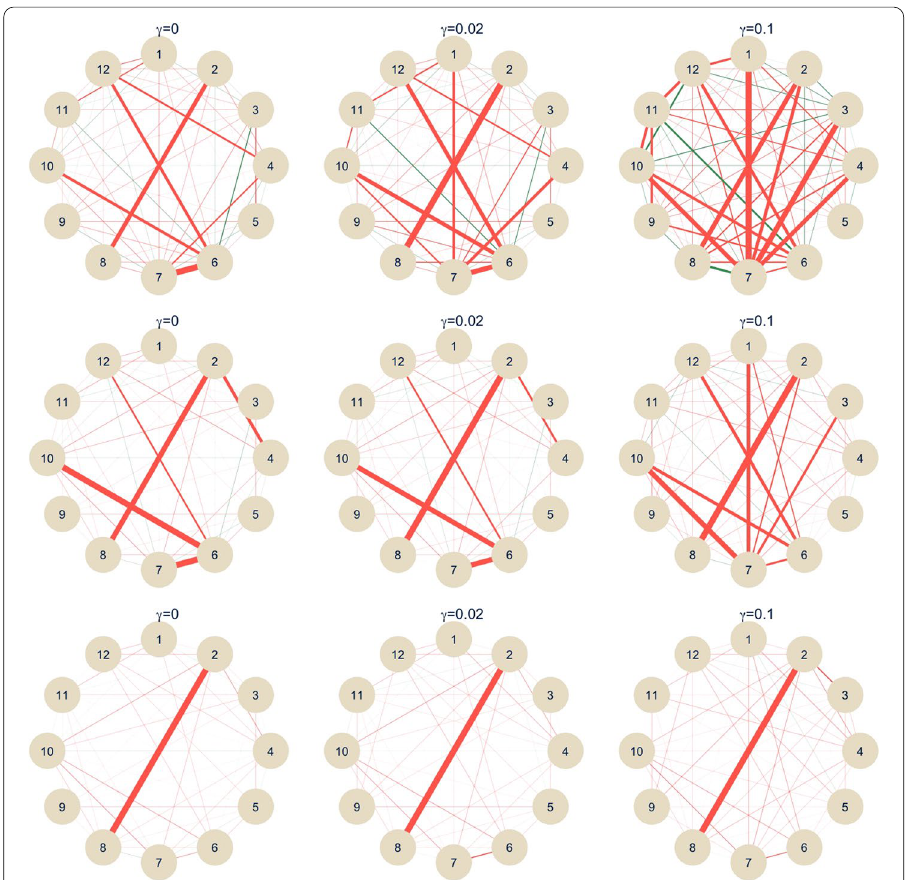
Fig. 6 Conditional correlations around January 18 2018, using the bandwidth parameter h = 20 (first row), h = 50 (second row) and h = 100 (third row). The parameter γ refers to the robustness parameter: γ = 0 means no robust